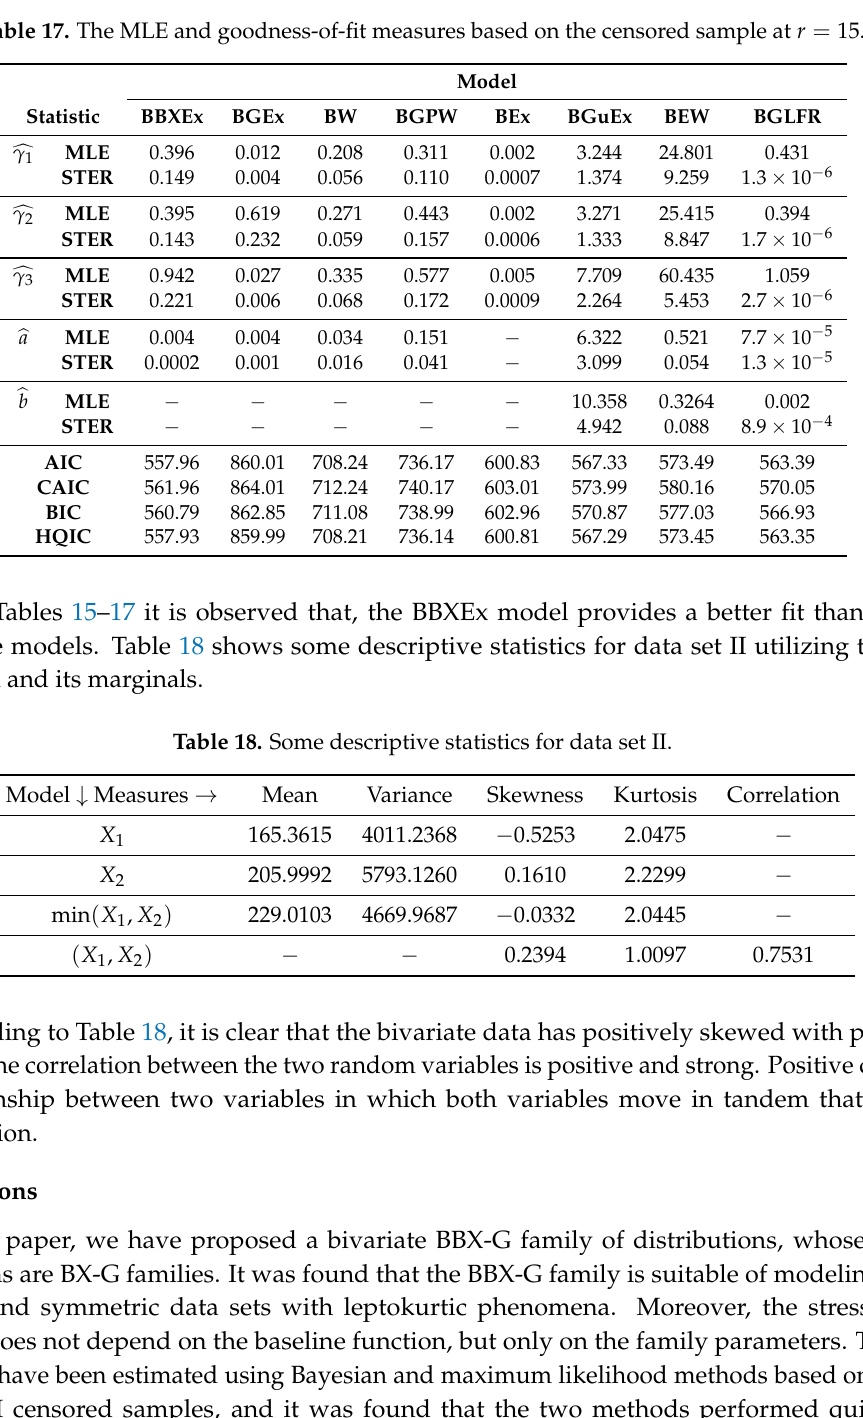
Table 17. The MLE and goodness-of-fit measures based on the censored sample at r = 15.